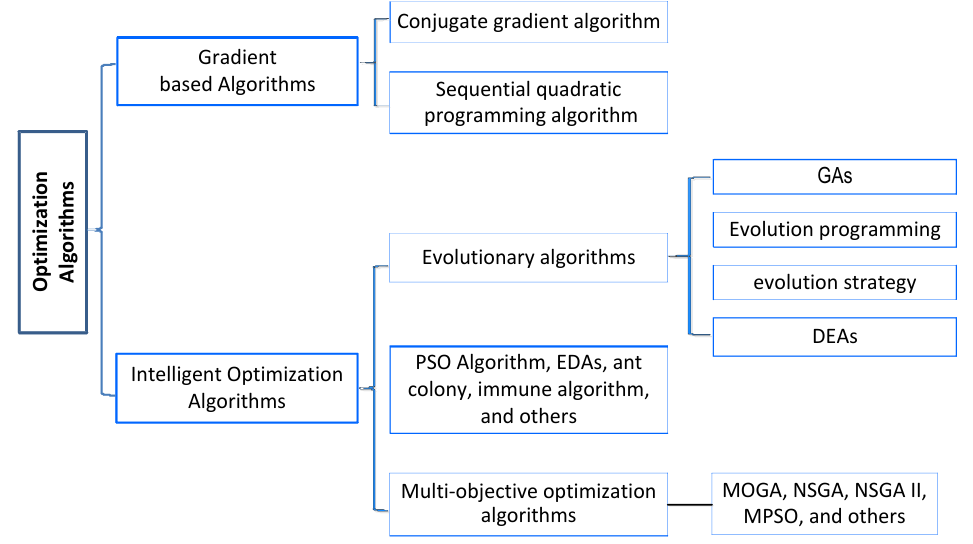
Figure 4. Popular optimization algorithms for design of electrical machines.